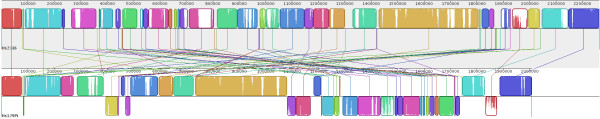
Alignment of the chromosomes of strains 2336 (top) and 129Pt (bottom) using MAUVE 2. Identically colored boxes, known as locally collinear blocks (LCBs), depict homologous regions in the two chromosomes. The edges of LCBs indicate chromosome rearrangements due to recombination, insertions, and/or inversions. Sequences of strain 129Pt inverted in relation to those of strain 2336 are shown as blocks below the horizontal line. The vertical lines connect regions of homology among the two chromosomes. Numbers above the maps indicate nucleotide positions within the respective chromosomes.